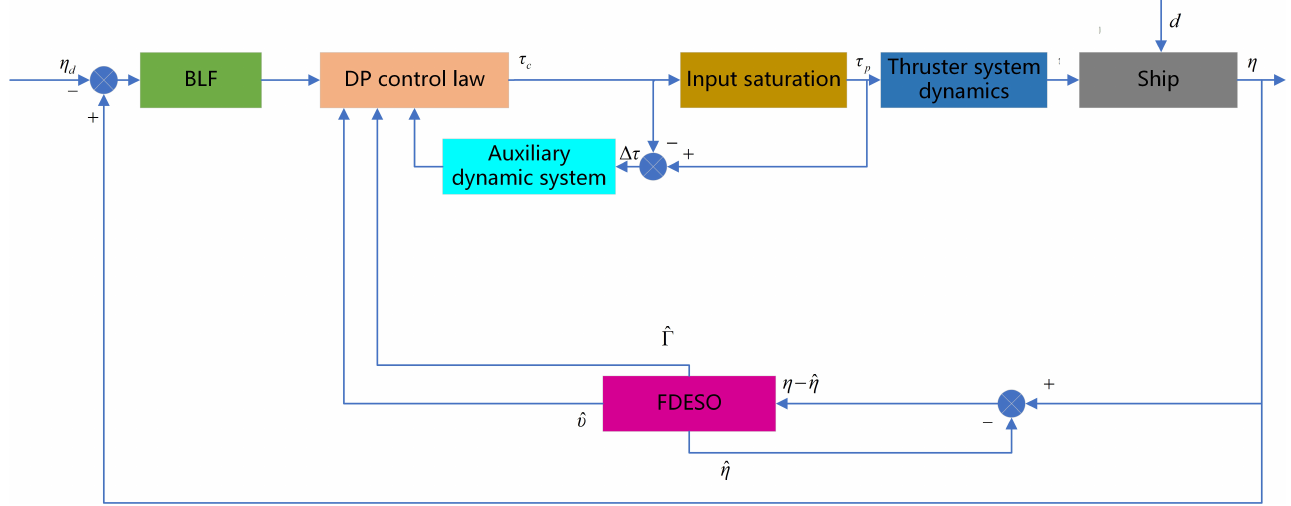
Figure 2. Schematic of DP control system for